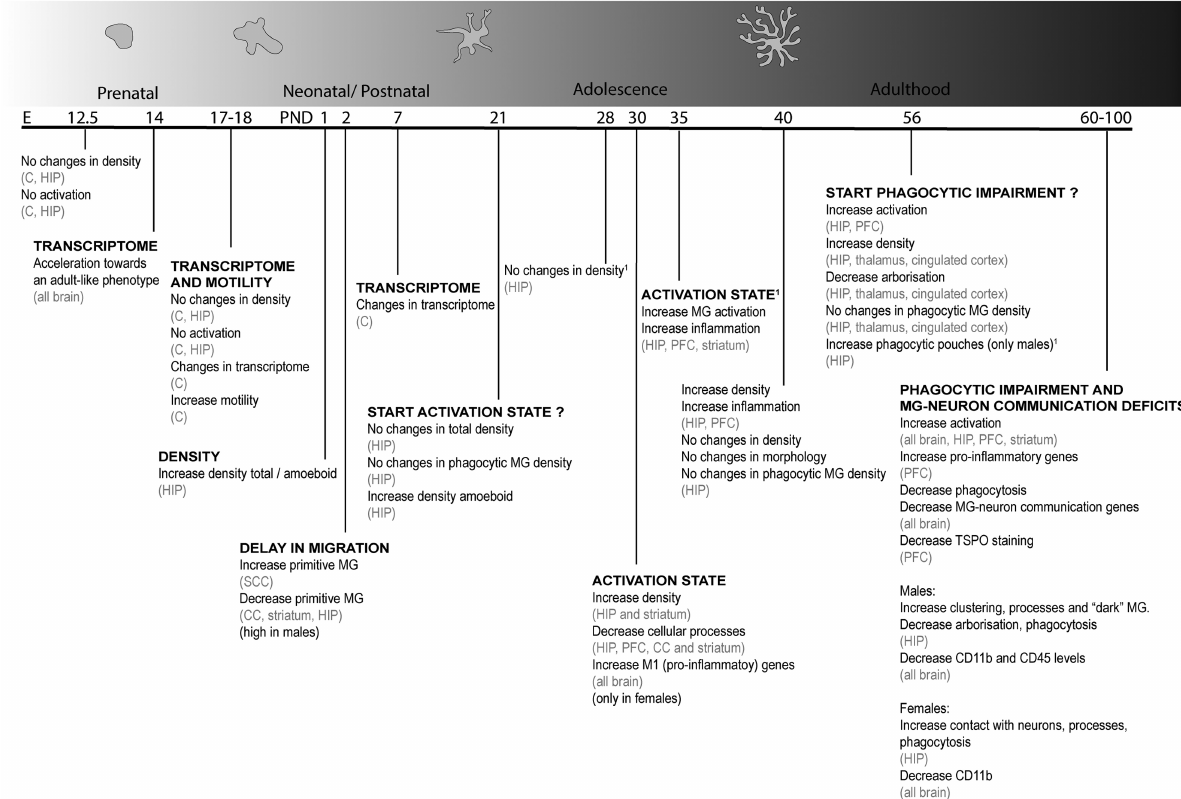
Fig. 3 Microglia sequelae in schizophrenia animal models. The alterations are organized in four periods of development: prenatal, neonatal, adolescence and adulthood. Titles in capital letters evidence the main alteration(s) observed at a particular period of life. ED embryonic day, PND postnatal day, MG microglia, C cortex, HIP hippocampus, SCC supraventricular cortex, CC corpus callosum, PFC prefrontal cortex.? imprecise time window of appearance of microglia alterations. 1 evidences from other SCZ animal